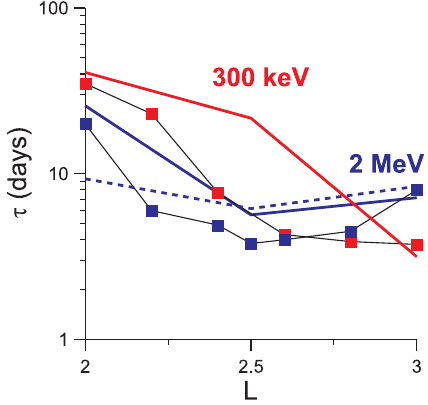
Fig. 22. Analytical lifetime estimates from Eq. (9) for L = 2 to 3 are compared with actual lifetimes measured by SAC-C and DEME- TER (Benck et al., 2010) for 300keV electrons and by SAMPEX ( Meredith et al., 2007) for 2MeV electrons. Lifetimes are esti- mated for interaction with quiet-time hiss and lightning-generated whistlers, with an additional contribution from higher-frequency whistler waves or magnetosonic waves required at low energy (see text). Blue color is for 2MeV and red color for 300keV, with squares indicating measured values. The dashed line shows the life- times from Eq. (14)